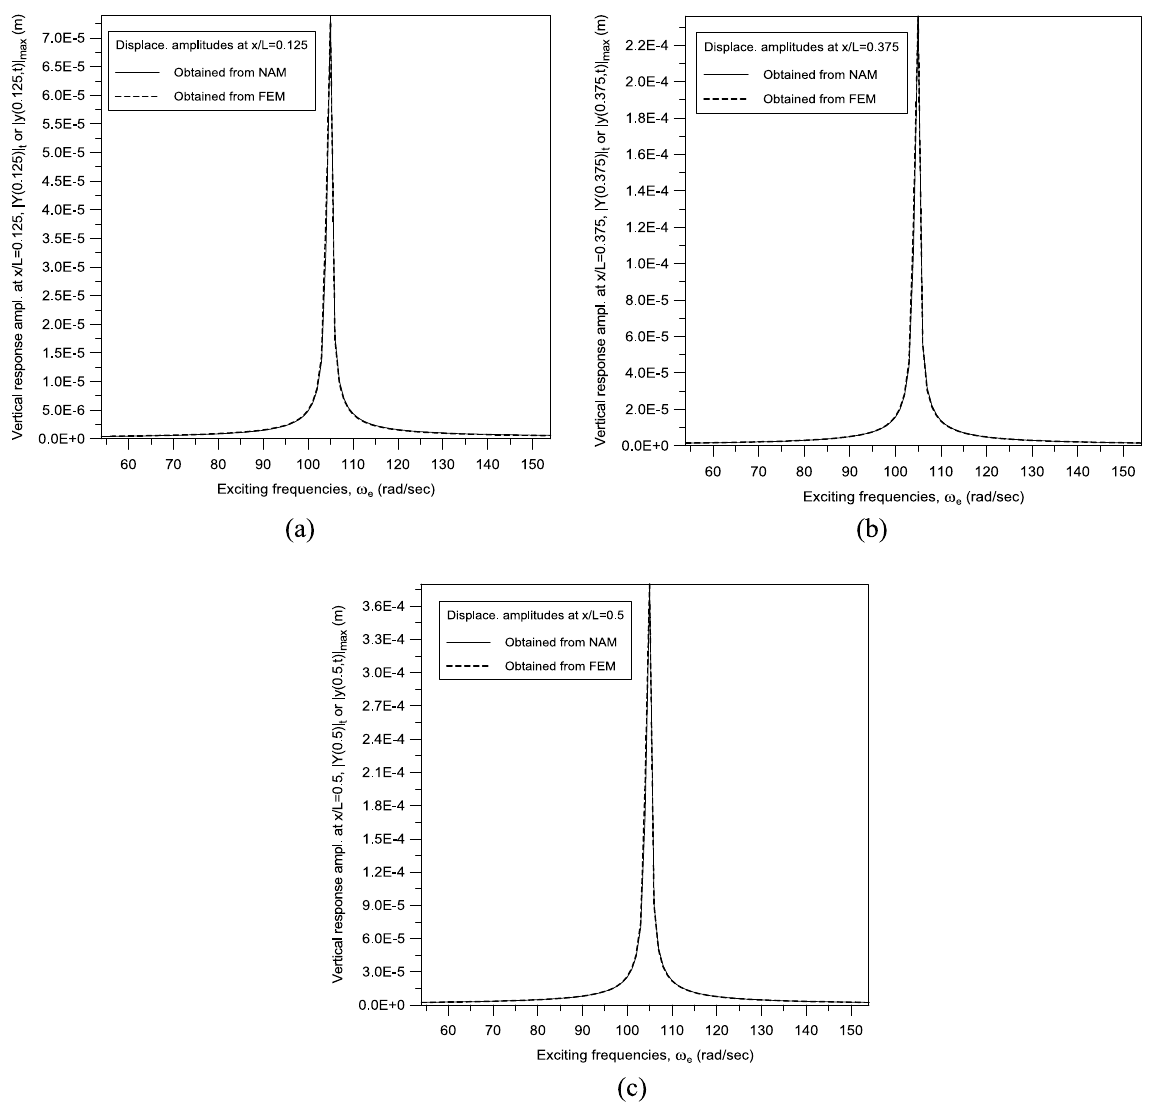
Fig. 8. The legend is the same as Fig. 7 except that this is for the vibrating system shown in Fig.